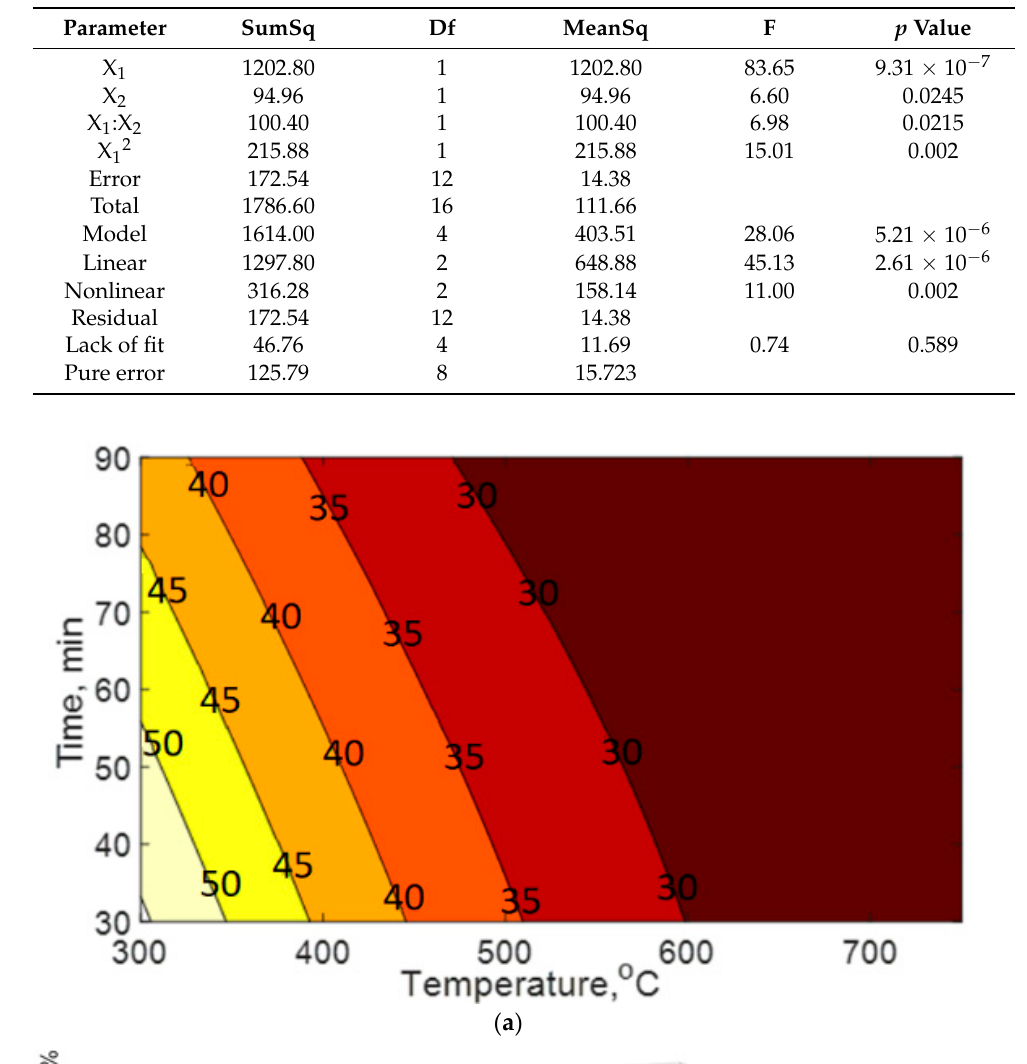
Table 4. ANOVA results for the reduced second-order polynomial model.